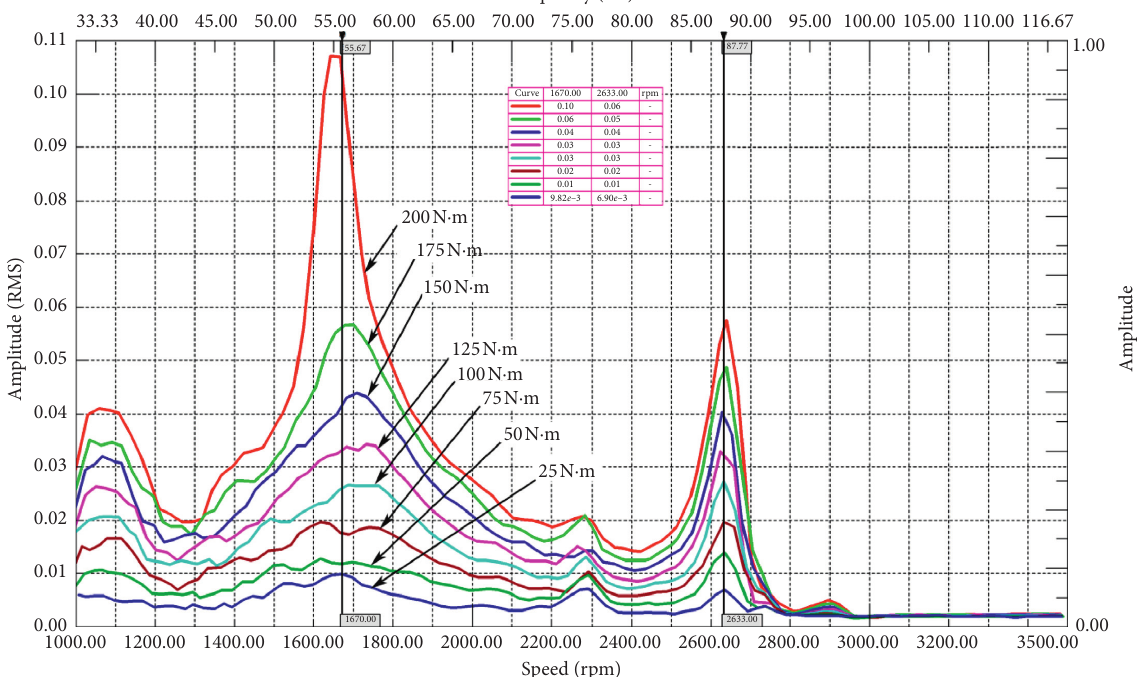
Figure 13: Amplitude-frequency responses of torsional vibration for output end of rear axle at different torque